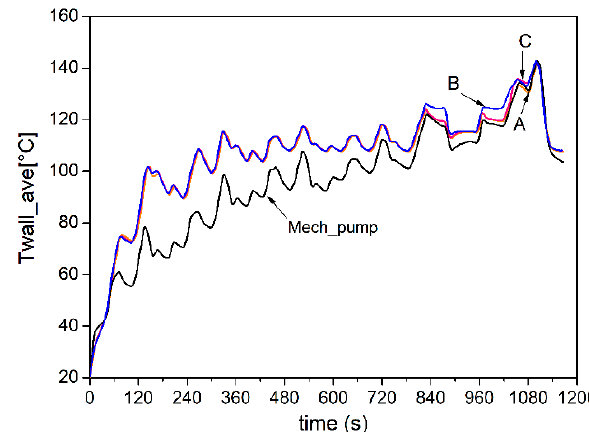
Figure 17. Average metal temperature during the NEDC.